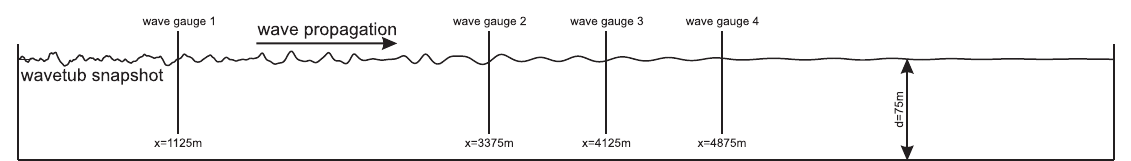
Figure 1. General scheme of the applied semi-experimental procedure for the irregular sea states investigations including validation